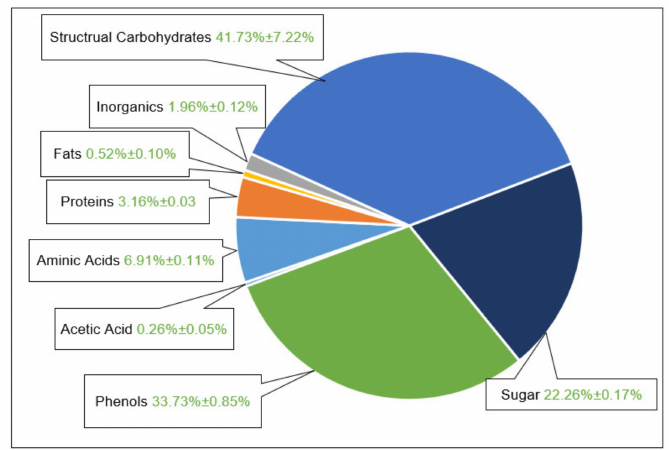
Figure 5. Overview of extracted dry mass